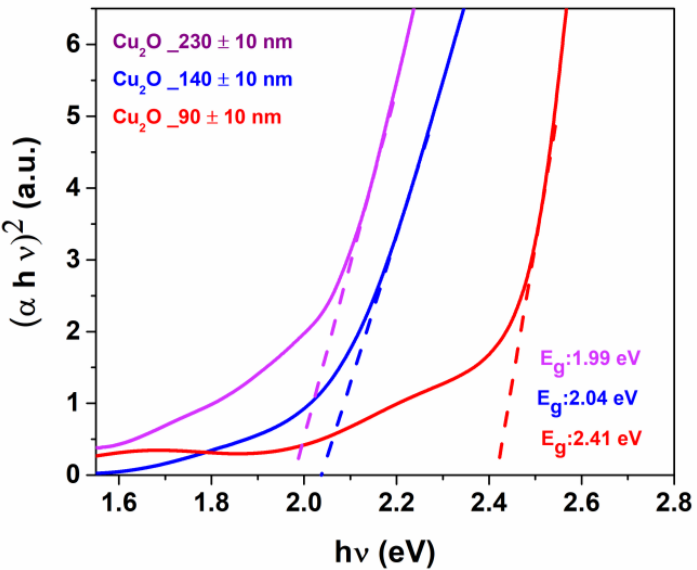
Figure 5. Tauc’s plot [( α h ν ) 2 against photon energy (h ν )] of Cu 2 O films on ITO_quartz with thickness of 230 nm (purple line); 140 nm (blue line) and 90 nm (red line).